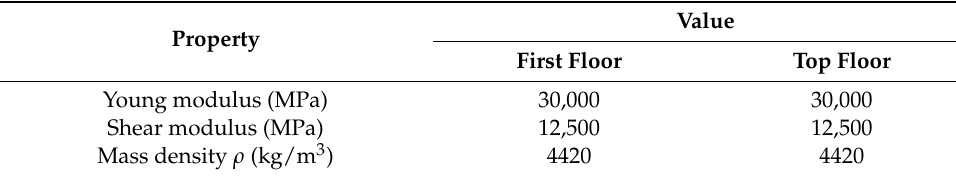
Table 6. Properties of the shell elements (thickness = 68 mm) representing the concrete slabs in configuration B2-RC.